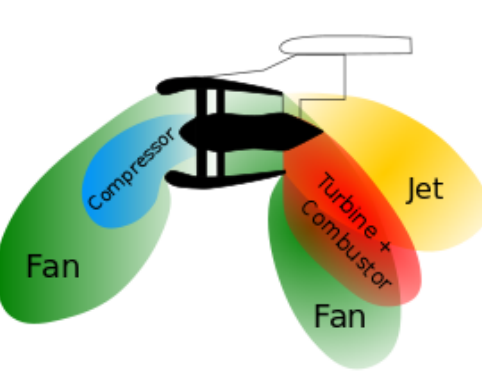
Figure 6. Typical noise directivity from components of a modern turbofan.